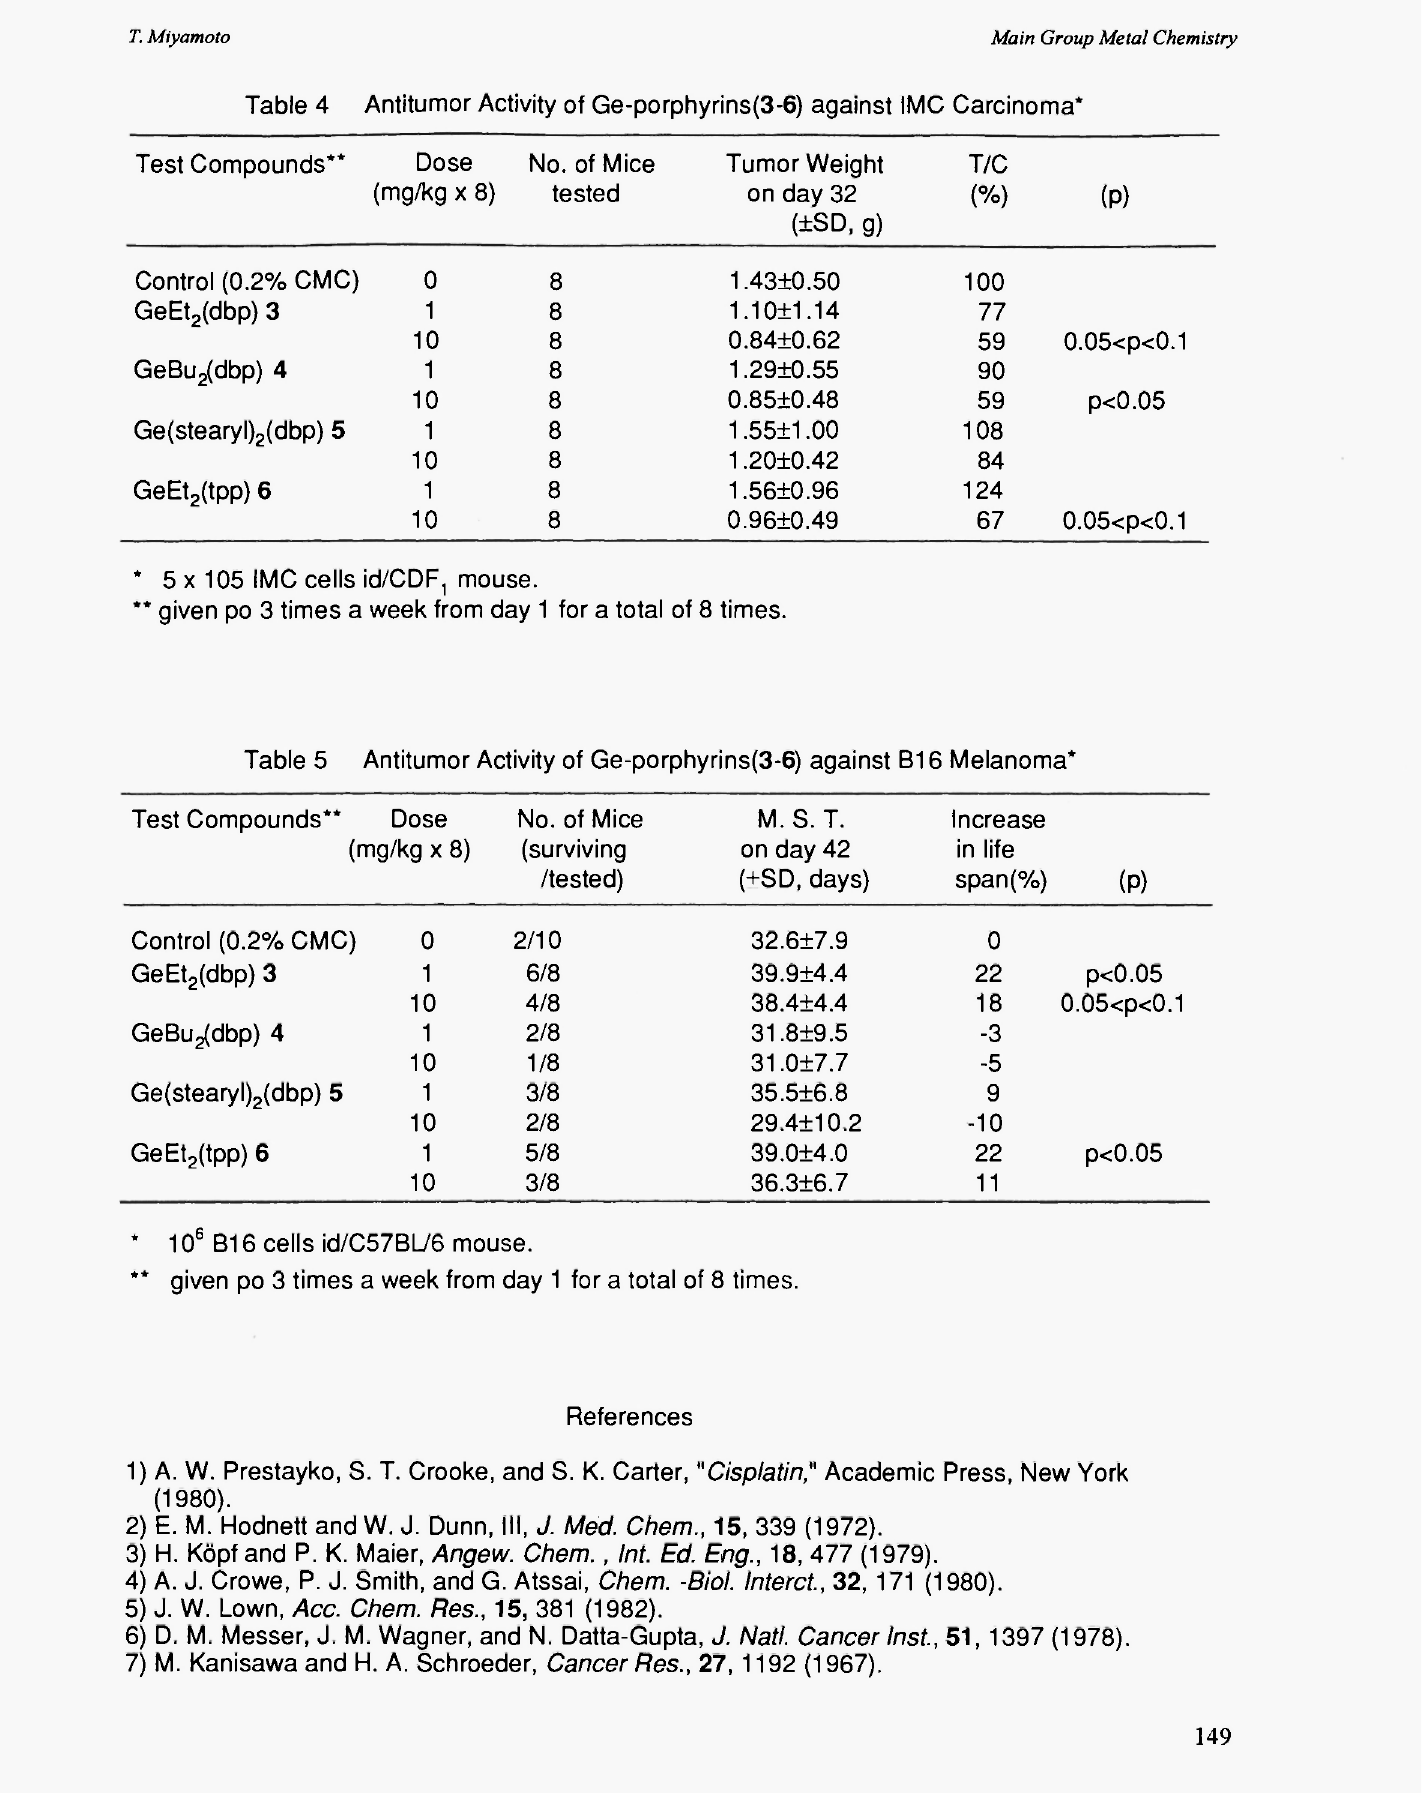
Antitumor Activity of Ge-porphyrins(3-6) against B16 Melanoma* Test